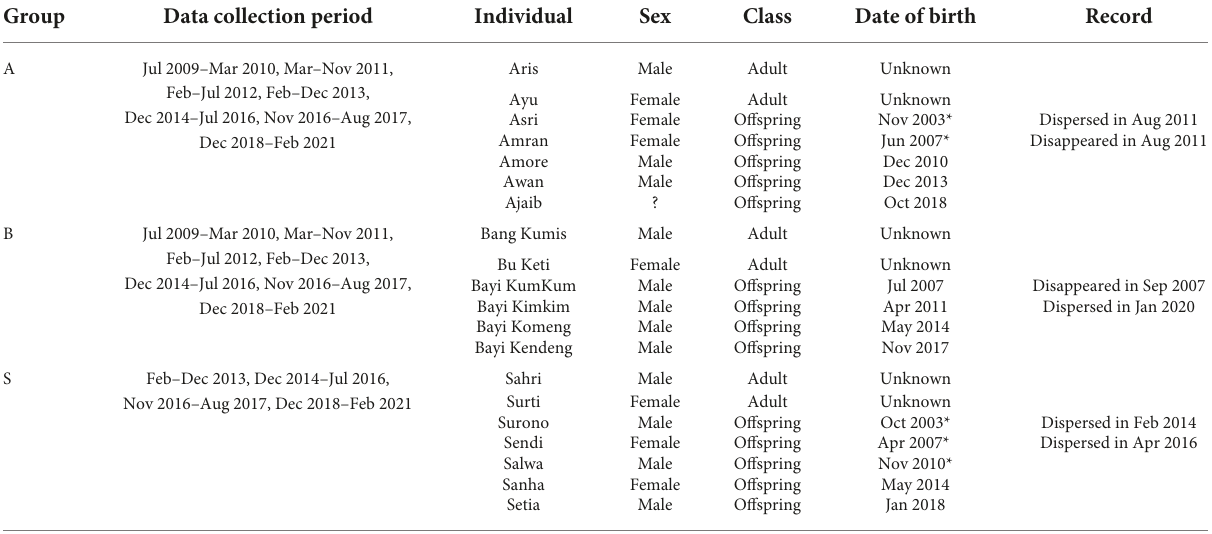
TABLE 1 The life history of the study subjects and data collection period for each gibbon group in Gunung Halimun-Salak National Park, Indonesia between 2009 and 2021.